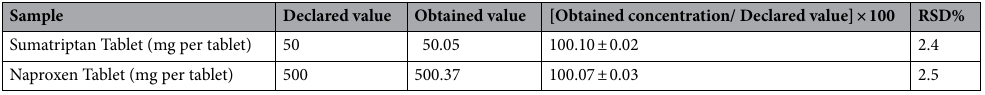
Table 2. Comparison of the total values of sumatriptan and naproxen of some pharmaceutical preparations obtained using Fe